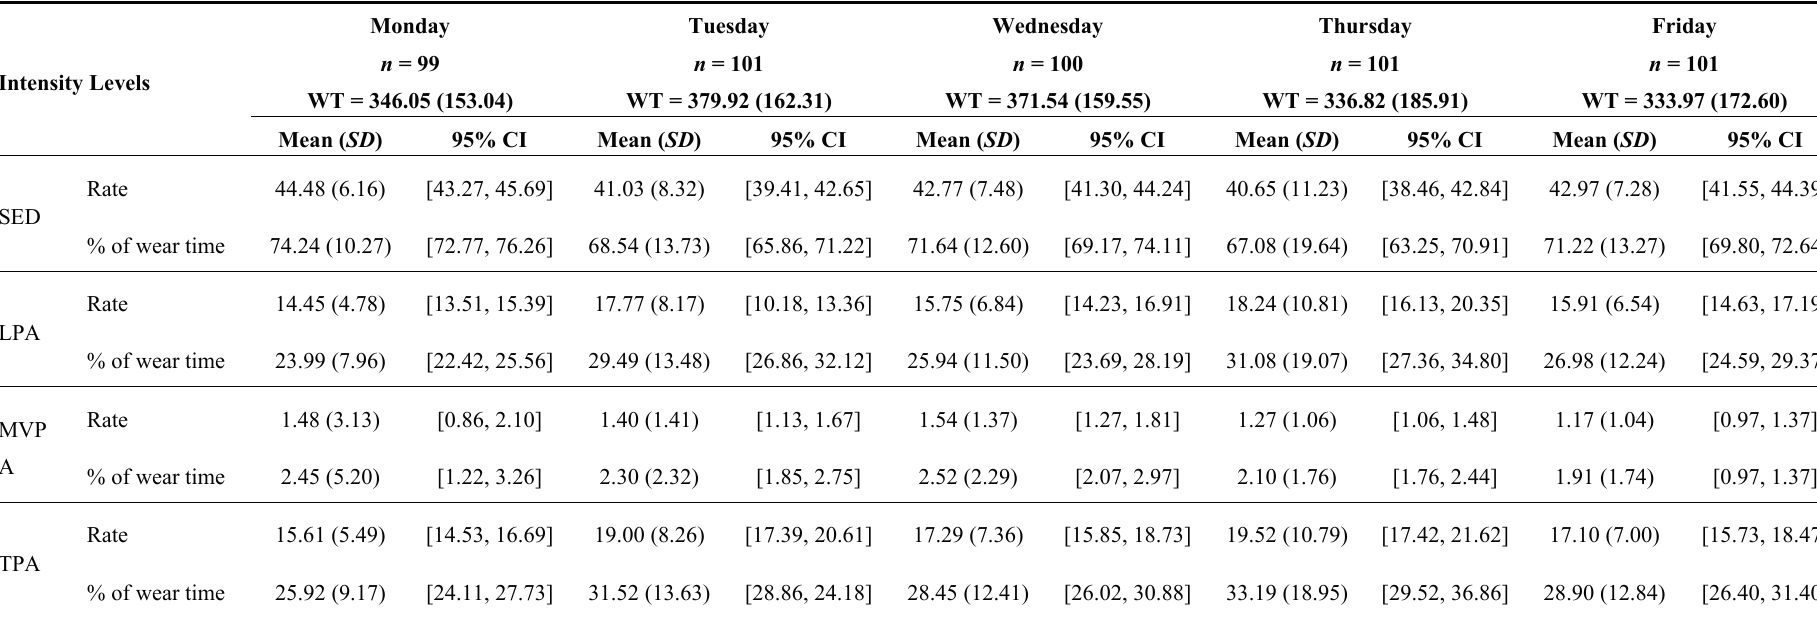
Table 1. Preschoolers’ Rates (in minutes/hour) and Percentage (of wear time) of Physical Activity and Sedentary Time across the Days of Week during Childcare Hours